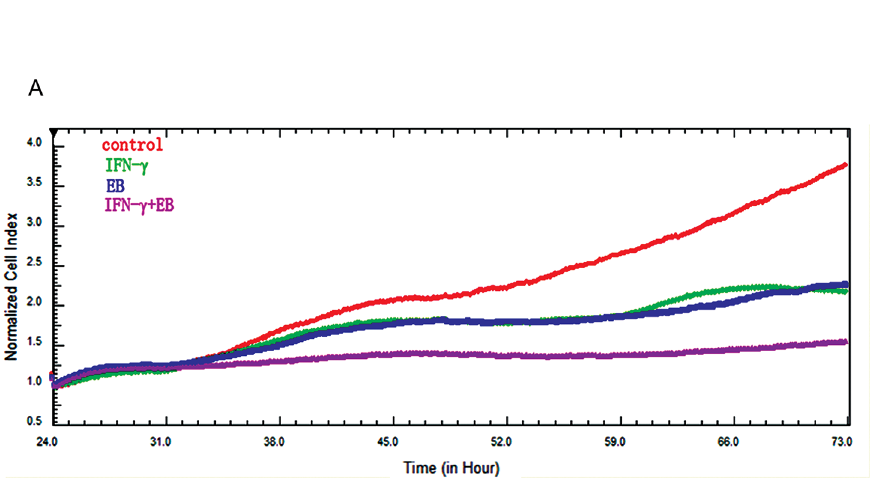
Fig 7. EB and IFN- γ synergistically inhibited tumor cell growth. ( A ) A549 cells were plated into a Real- Time Cell Analyzer (RTCA) for 24 h. IFN- γ (10000 U), EB (1 μ M), or their mixture were then added. The cell growth was recorded by the Real-Time Cell